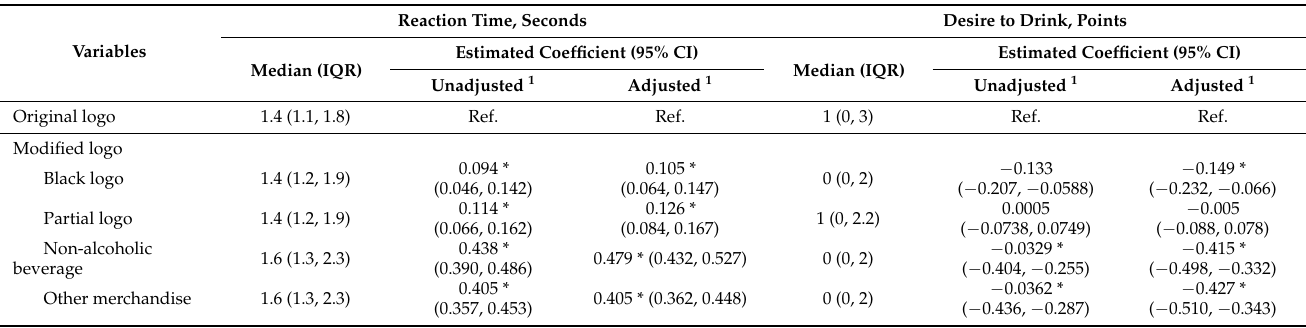
Table 2. Median and multivariate regression analyses on alcohol recognition using reaction times and scores on the desire to